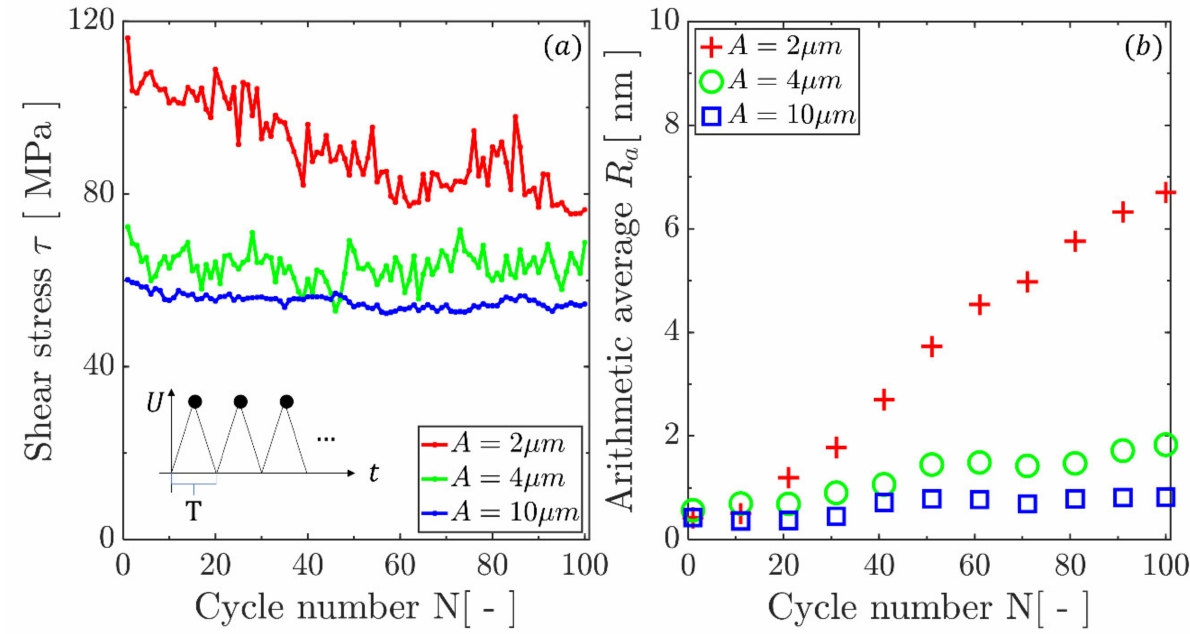
Figure 4. Cyclic behaviour of ( a ) peak shear stress that is obtained at the maximum sliding distance of a loading cycle and ( b ) roughness along the contact surface (represented by arithmetic average R a ) under three different contact sizes. Results were obtained from fretting calculations without preceding